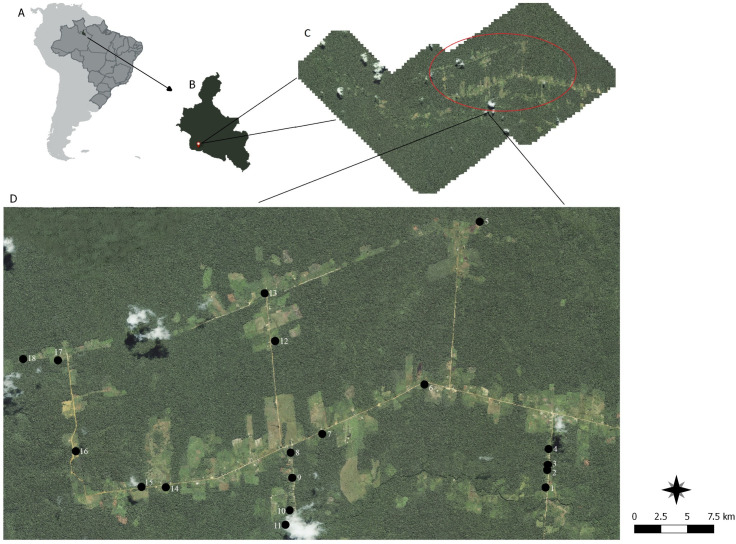
Study area geographical information system.A—In different shades of grey; South America, Brazil, and the municipality of Presidente Figueiredo. B—Delimitation area of the Presidente Figueiredo municipality, pointing to the agrovillage of Rio Pardo. C—Rio Pardo agrovillage and, in particular, roads where larvitraps were distributed for immature mosquito collection. D—Location of collection points along agrovillage roads: the numbers represent the geographic coordinates of the collection points: 1 (01º48’37.6” S, 060º16’27.1” W); 2 (01º48’26.7” S, 060º16’26.1” W); 3 (01º48’23.5” S, 060º16’25.7” W); 4 (01º48’13.6” S, 060º16’25.2” W); 5 (01º45’51.6” S, 060º17’08.2” W); 6 (01º47’33.3” S, 060º17’42.7” W); 7 (01º48’30.4” S, 060º18’46.8” W); 8 (01°48’15.9” S, 060°19’06.3” W); 9 (01°48’31.6” S, 060°19’05.3” W); 10 (01°48’51.9” S, 060°19’ 06.9” W); 11 (01°49’00.9” S, 060°19’09.5” W); 12 (01°47’06.1” S, 060°19’15.9” W); 13 (01°46’36.3” S, 060°19’22.5” W); 14 (01º48’37.5” S, 060º20’24.2” W); 15 (01º48’37.3” S, 060º20’39.4” W); 16 (01º48’15.0” S, 060º21’20.4” W); 17 (01°47’18.2” S, 060°21’31.6” W); 18 (01°47’17.4” S, 060°21’53.3” W). Reprinted from Maxar under a CC BY license, with permission from Instituto Leônidas e Maria Deane—Fiocruz, original copyright 2008.